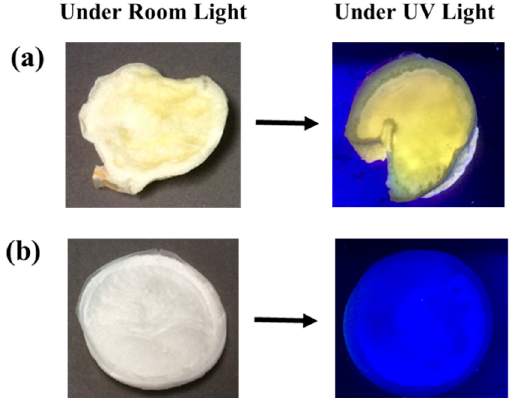
Figure 1. Digital photographs of the films under room light and UV light ( a ) cellulose-cadmium- tellurium quantum dots (cellulose-CdTeQD) and ( b ) cellulose film.